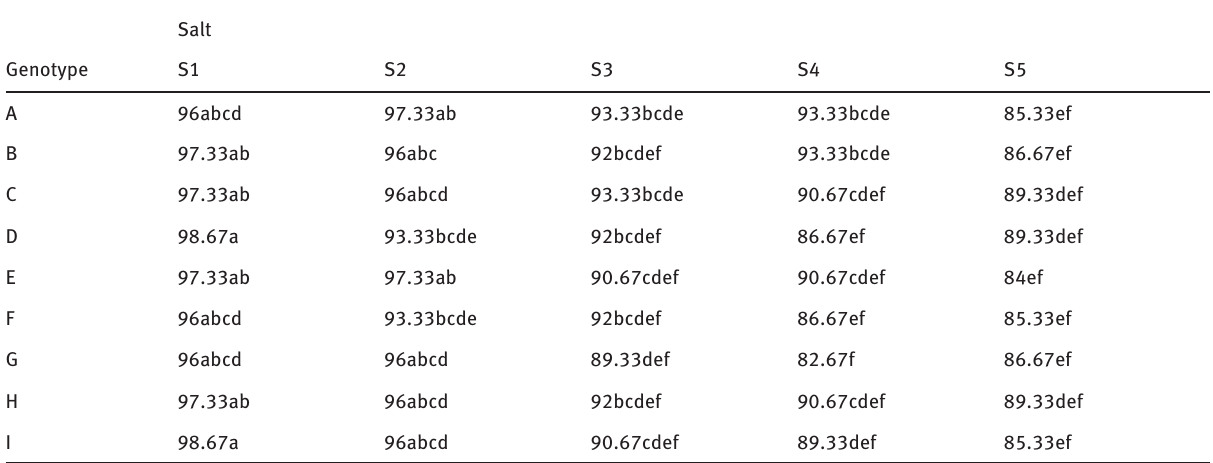
Table 2: Statistical comparison of means for genotype germination percentages by Duncan ’ s multiple range test (α = 0.01)